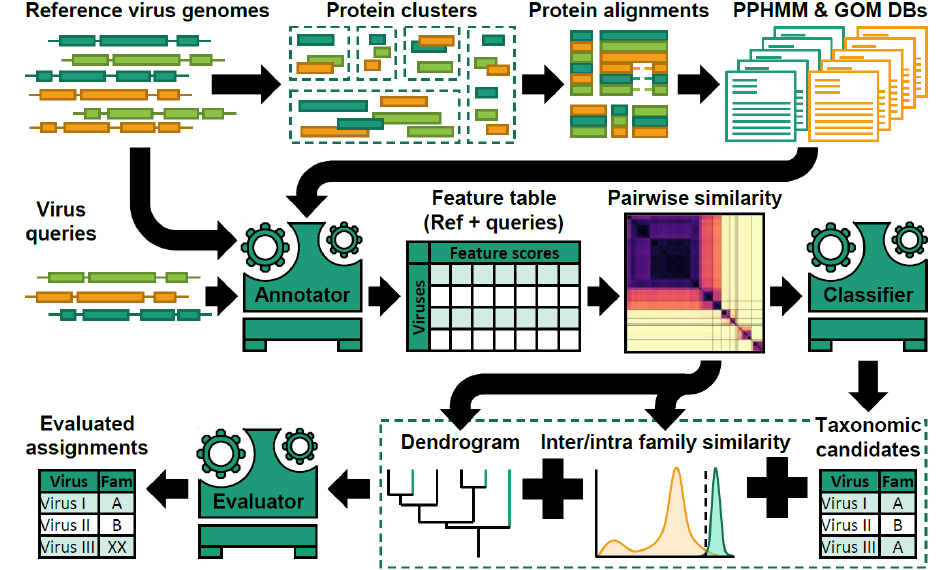
Figure 4. Overview of virus taxonomy prediction by “Genome Relationships Applied to Virus Taxonomy” (GRAViTy). A simplified diagram of the steps used to construct profile tables from sequences of viruses with assigned taxonomic status (reference virus genomes). It further illustrates the steps to classify viruses of of undetermined taxonomic relationships. The method is based on extraction of protein sequences from reference virus genomes and their clustering using pairwise BLASTp bit scores. Sequences in each cluster are then aligned and turned into a Protein Profile Hidden Markov Model (PPHMM). Reference genomes are subsequently scanned against the database of PPHMMs to determine the locations of their genes, and Genomic Organisation Models (GOMs) for each virus family are constructed. These models form the core of the genome annotator (Annotator), which is used to annotate query sequences with information on the presence of genes and the degree of similarity of their genomic organisation to reference virus sequences. From this, genome relationships can be extracted by computation of various genetic distance metrics, including composite generalised Jaccard similarity, which forms the basis for heat maps and dendrograms that depict the relationships of query sequences to the dataset of classified viruses (Classifier) and recommendations for their taxonomic assignments